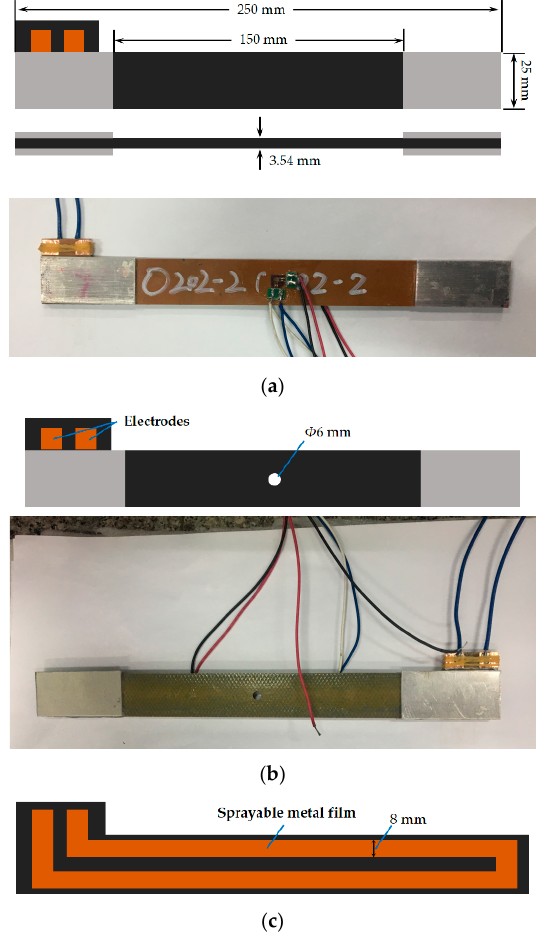
Figure 2. Dimensions of specimens: ( a ) specimen used in temperature and static tensile tests; ( b ) specimen used in thermal and mechanical cycles tests; ( c ) circuit of the sprayable metal film (SMF).